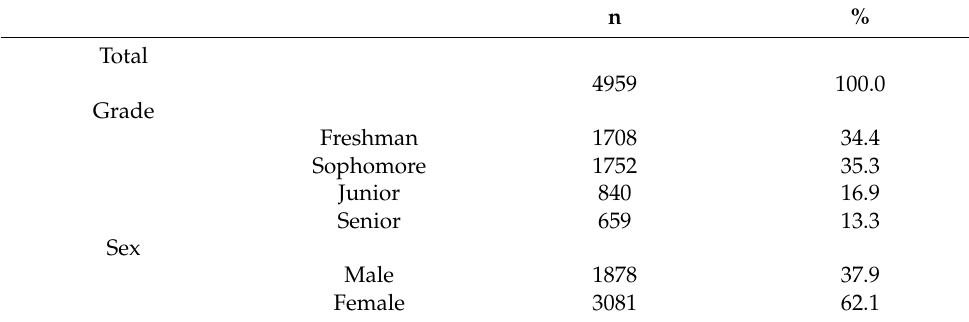
Table 1. Demographic characteristics of the study participants (n =